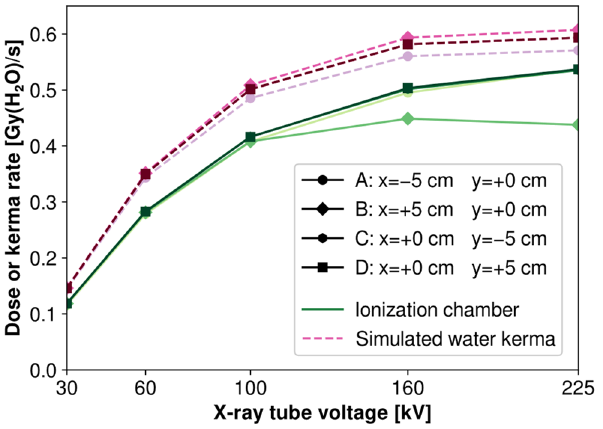
Figure 9. Dose rate measured by the ionization chamber (solid line) and simulated water kerma rate (dashed line) at five tube voltages and four points in a radius of 5 cm around locations corresponding to the center of the irradiated OFs.